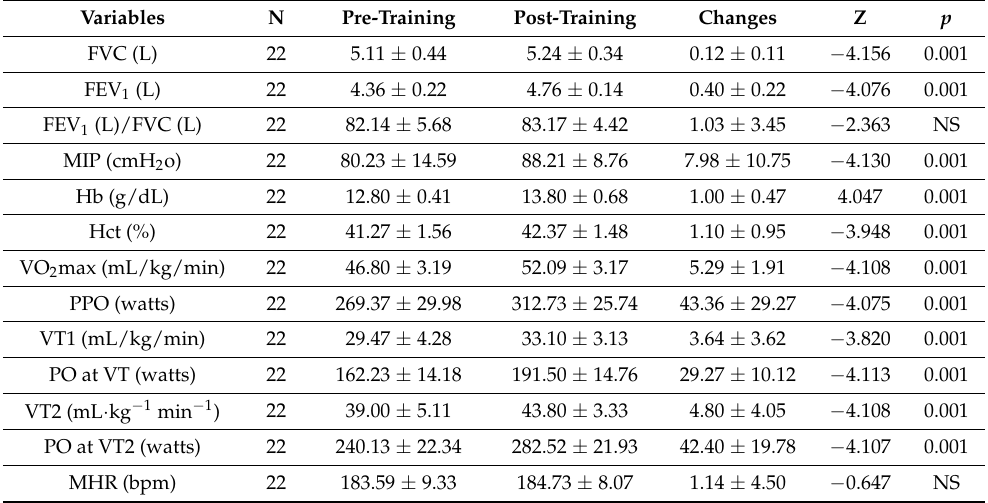
Table 3. Pulmonary function, hematological variables, and cardiorespiratory fitness biomarkers: a comparison of the pre- and post-test changes in the experimental group (n = 22).